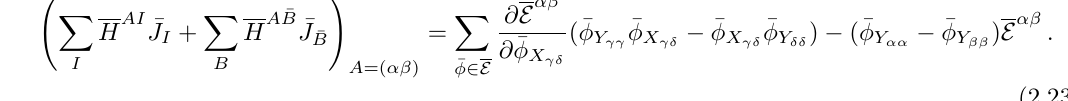
; (cid:22)(cid:3) (cid:22) ) schematically read as follows A A